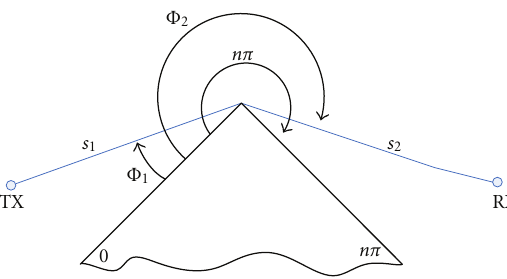
Figure 6: Geometry for wedge di ff raction coe ffi cients.